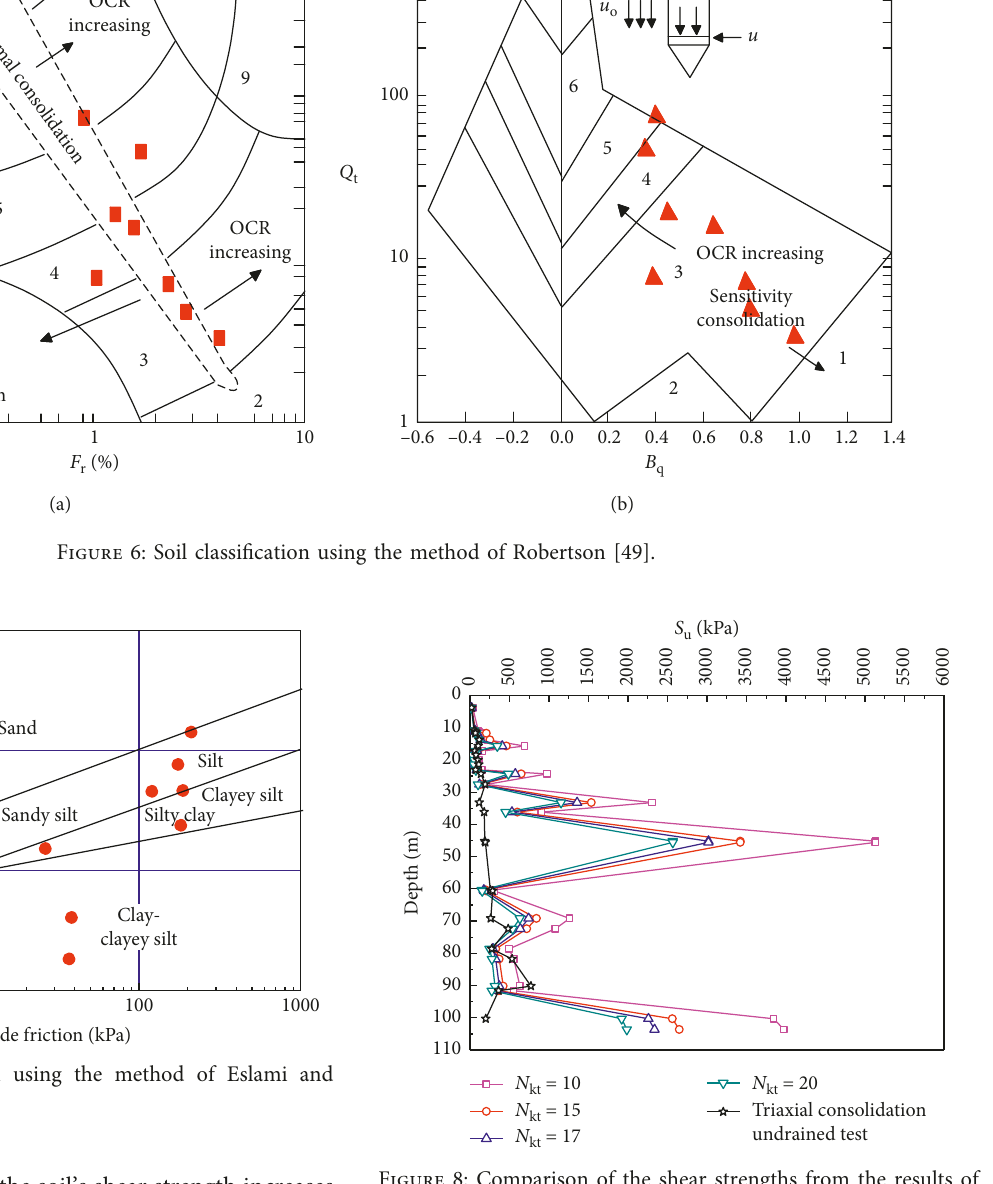
Figure 8: Comparison of the shear strengths from the results of undrained unconsolidated triaxial tests and CPTtests with different N kt